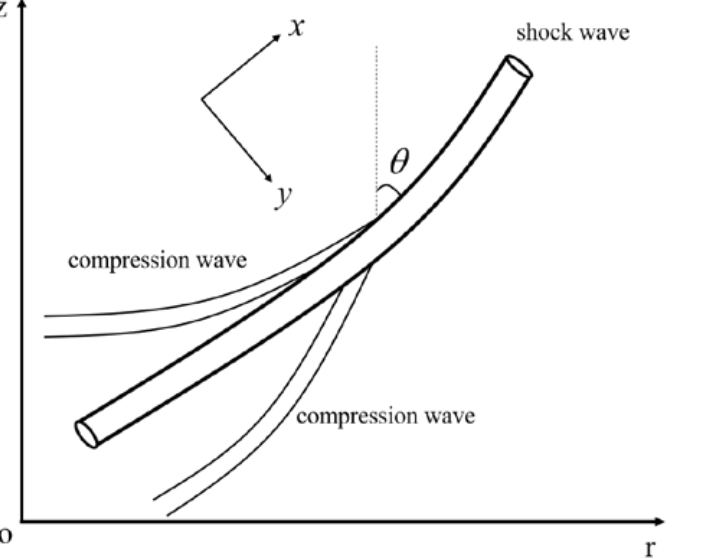
Figure 4. Convergence from compression wave into shock wave in the orthogonal coordinate (x, y).